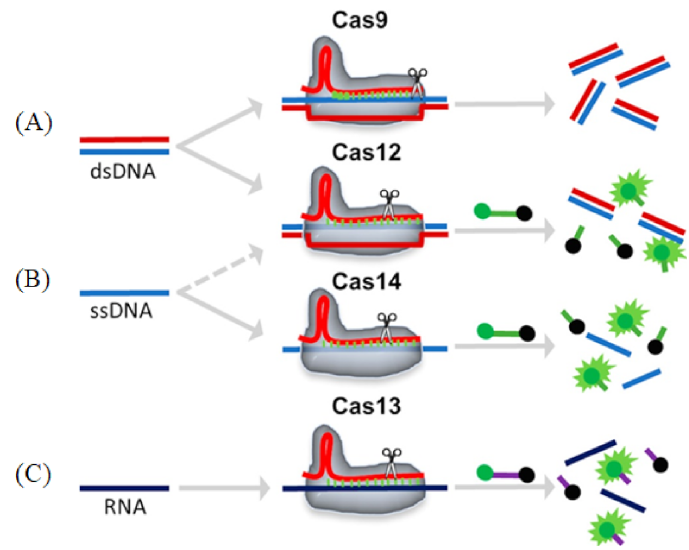
Figure 6. Schematic representations of different Cas enzyme activities. Reprinted with permission from Ref. [99]. Copyright 2020, Suea-Ngam et al. ( A ) Cas9: The target dsDNA is cis-cleavage after binding to the gRNA-Cas9 complex. ( B ) Cas12/14: The target ds/ssDNA binds to the gRNA-Cas12 complex and is cis-cleavage, followed by an ssDNA that is trans-cleavage and releases a fluorescence signal. ( C ) Cas13: The target RNA binds to the gRNA-Cas13 complex and is cis-cleavage, followed by an ssRNA that is trans-cleavage and releases a fluorescence